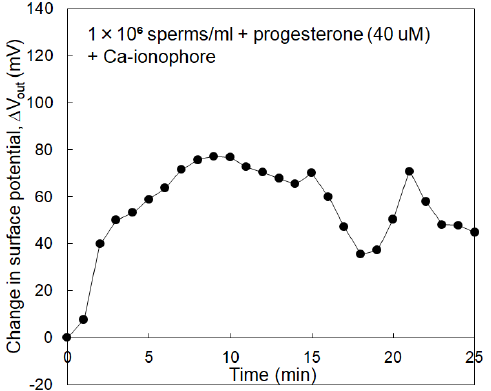
Figure 3. Change in surface potential of sperm-cultured gate ISFET sensor. Spermatozoa were added in the measurement medium at 0 h, which included progesterone at a concentration of 1–60 µ M; ( a ) 1 × 10 5 sperm/mL, ( b ) 1 × 10 6 sperm/mL, ( c ) 1 × 10 6 sperm/mL in the Ca 2+ -free HTF medium containing Ca ionophore.